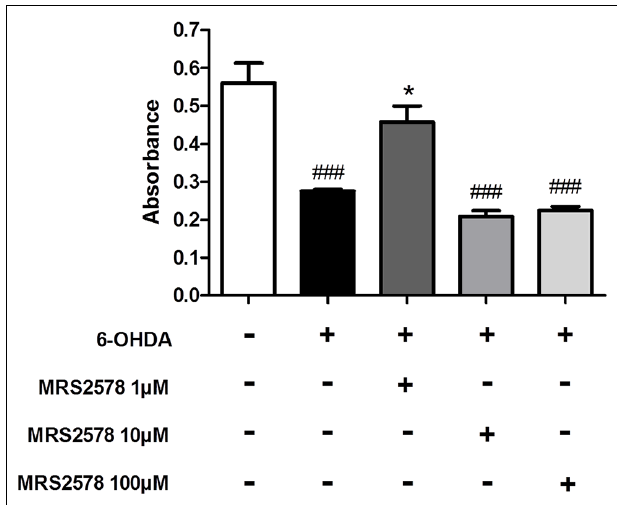
FIGURE 7 | Cell viability after 6-OHDA insult. Cell viability of differentiated SH-SY5Y human cells in dopaminergic neurons, treated with MRS2578 (MRS) at doses of 1, 10 and 100 µ M for 30 min and induced to death for 24 h by 6-OHDA (100 µ M) was tested by the MTT reduction assay. Absorbance at 600 nm is expressed as mean ± standard errors of the mean. ∗ p < 0.05 compared to group with 6-OHDA-induced death without treatment; ### p < 0.001 in relation to control group; n = 3. One-way ANOVA followed by the Bonferroni post hoc